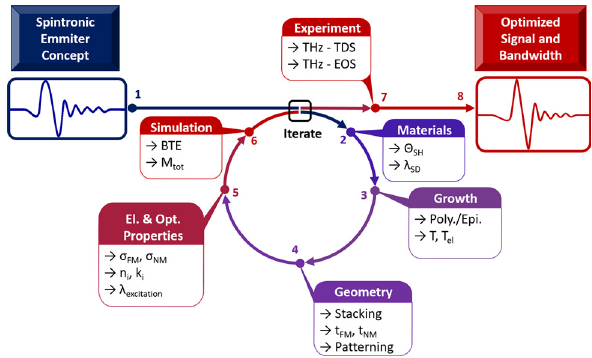
Figure 3: Roadmap to efficient spintronic THz-emitters with high signal strength and broad bandwidth. Here, Θ SH is the spin Hall angle, λ SD is the spin-diffusion length, T and τ el are the interface transmission parameter and the elastic scattering lifetime, respec- tively. t FM , t NM , σ FM and σ FM are the FM and NM layer thickness and electrical conductance, respectively. n i and κ i are the index of refraction and the absorption coef fi cient of all involved layers (metals and insulators) in the THz range, respectively. λ excitation is the wavelength of the laser excitation. BTE refers to the Boltzmann transport equation, M tot is the transfer matrix used to describe the propagation of the generated THz wave throughout the total layer stack. THz-detection schemes are de fi ned as THz-TDS for the time domain spectroscopy and THz-EOS for the free space electro-optical sampling. Figure modi fi ed from the study by Nenno et al.